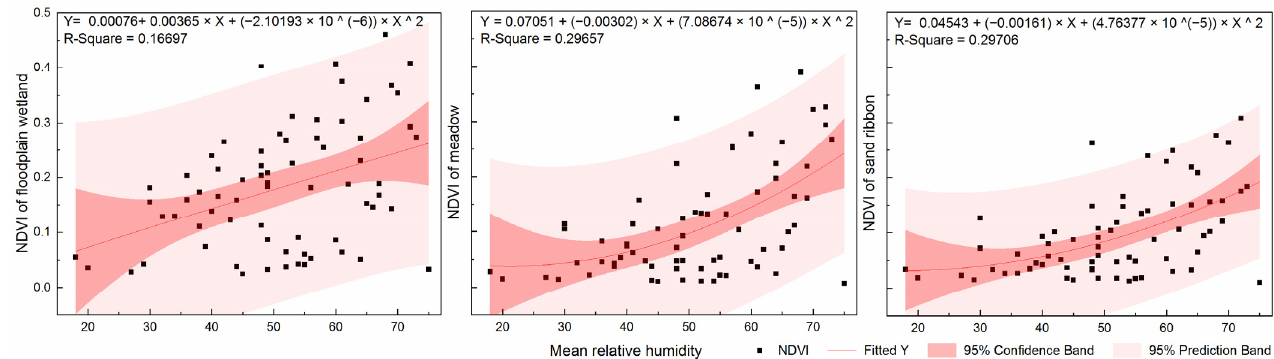
Figure 8. NDVI-humidity sca tt er fi tt ing